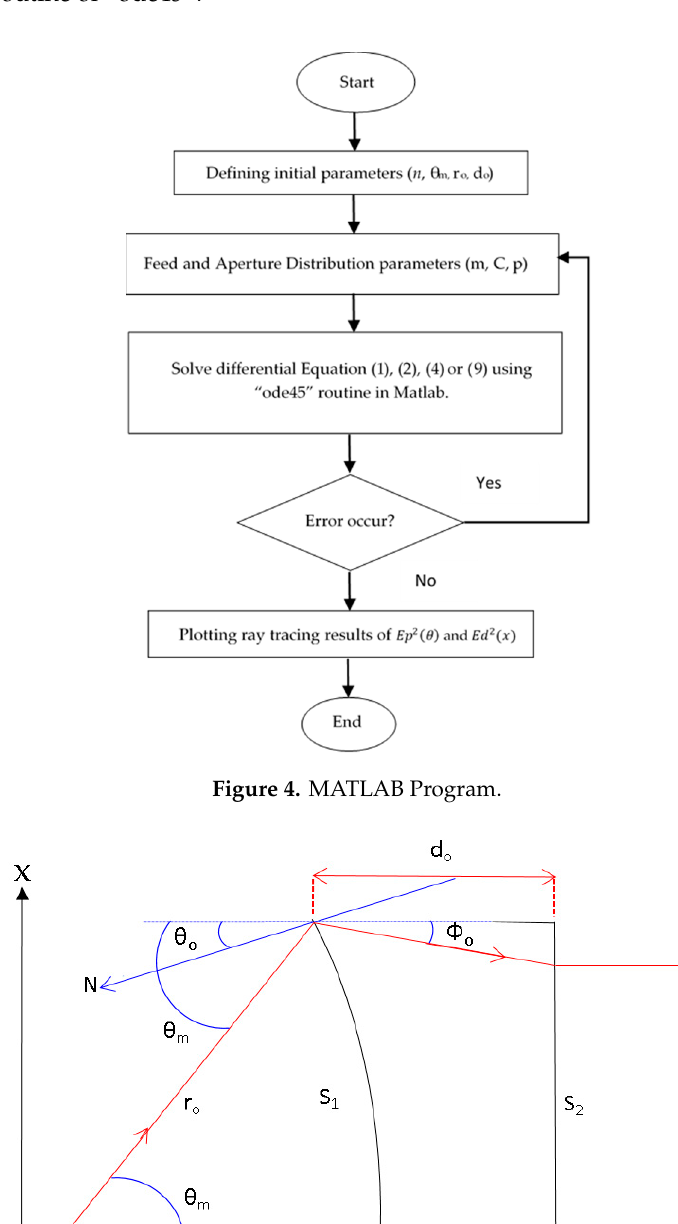
Figure 5. Initial parameters at the lens edge.